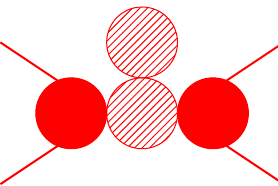
Figure 7. Example of a diagram with 4 external legs and a massless tadpole: the external and internal blobs are characterized by filled or patterned color respectively. The color indices in the two external propagators on each side are the same. The blobs stand for connected diagrams with propagators and single trace vertices belonging to the first sector. The vertices at which the external blobs connect to the lower internal blob and the vertex connecting the two internal blobs correspond to the double trace coupling e f . The internal blob on the top is a massless tadpole. 1